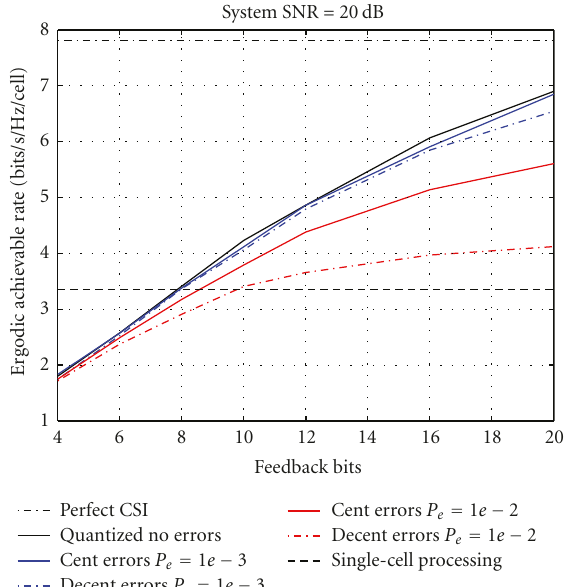
Figure 6: A plot of the ergodic achievable rate as a function of the number of feedback bits for a random codebook when System SNR is 20dB and round-robin scheduling is employed. The blue curves correspond to the case where the bit error probability is P e = 10 − 3 , whereas for the red curves P e = 10 − 2 . “Cent” denotes the centralised framework and “Decent” the decentralised one. It can be noted that we need at least 20bits in order to approach the performance of the perfect CSI case in the absence of feedback errors (black uppermost line).